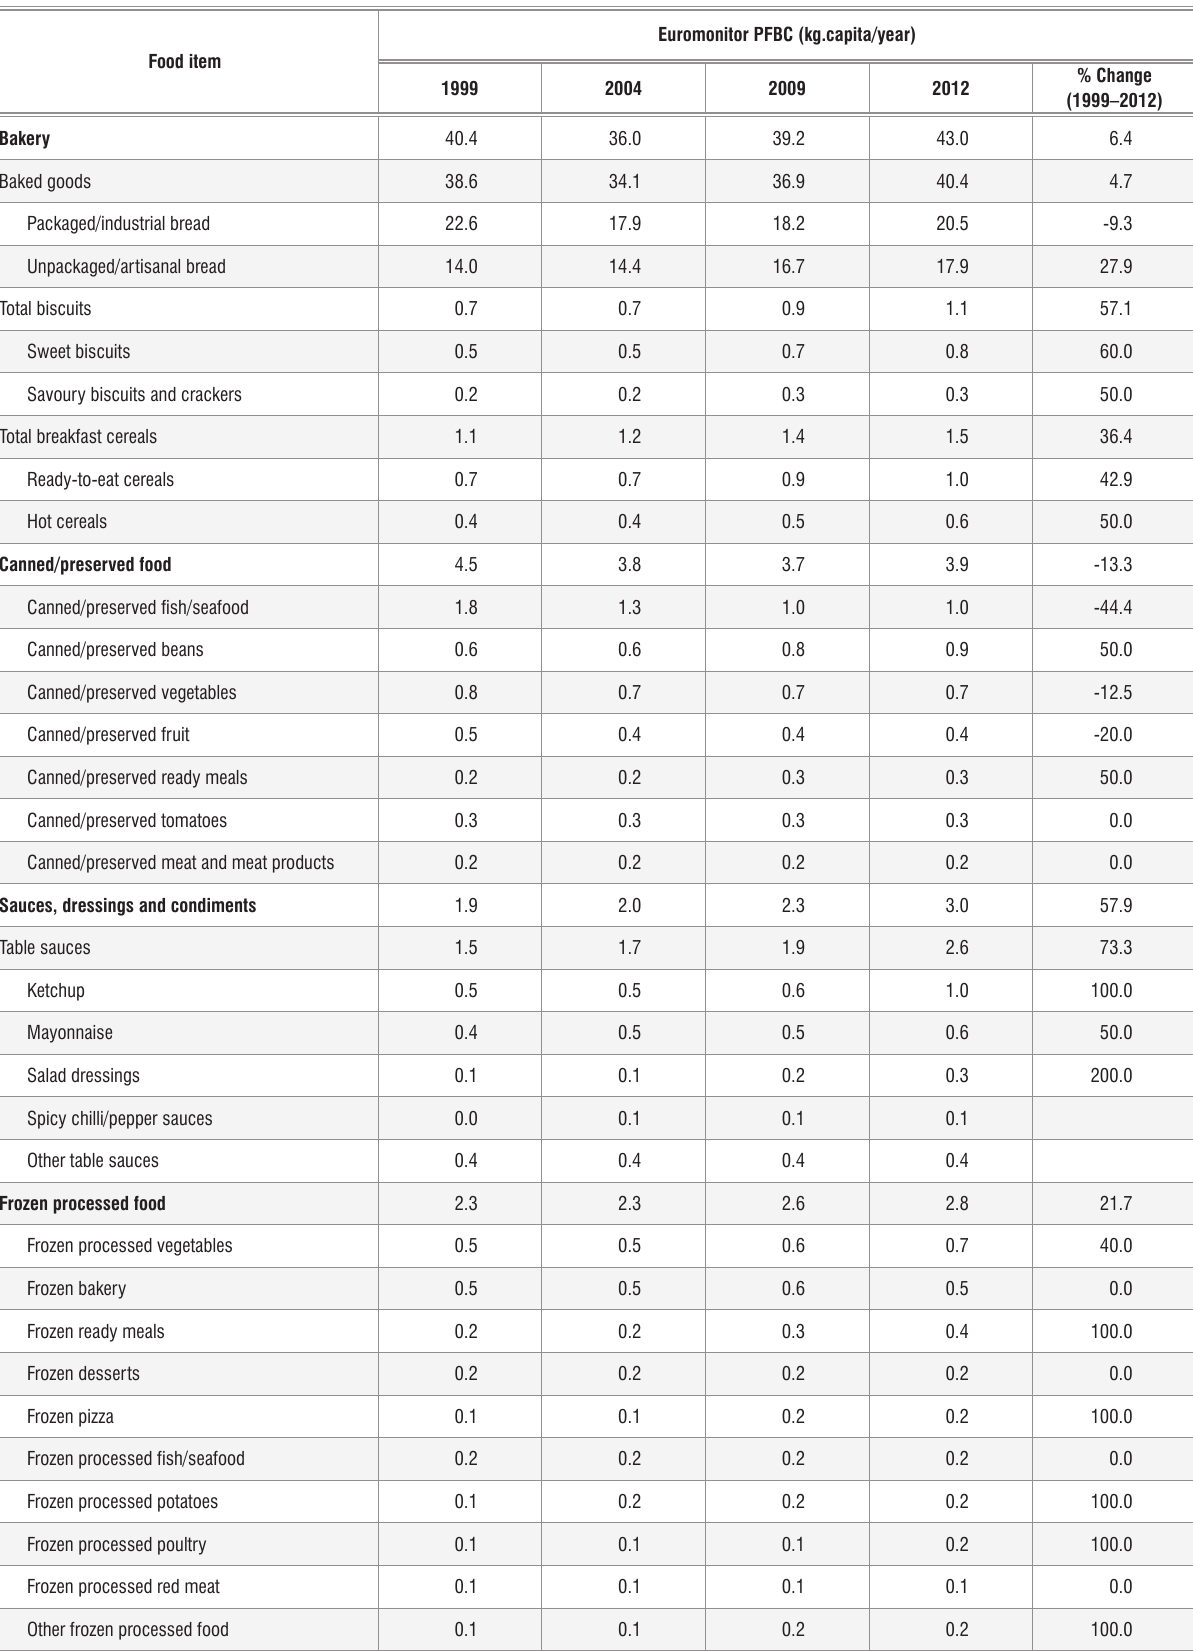
Table 8: Consumption of packaged foods in South Africa according to Euromonitor Packaged Food and Beverage Consumption (PFBC)